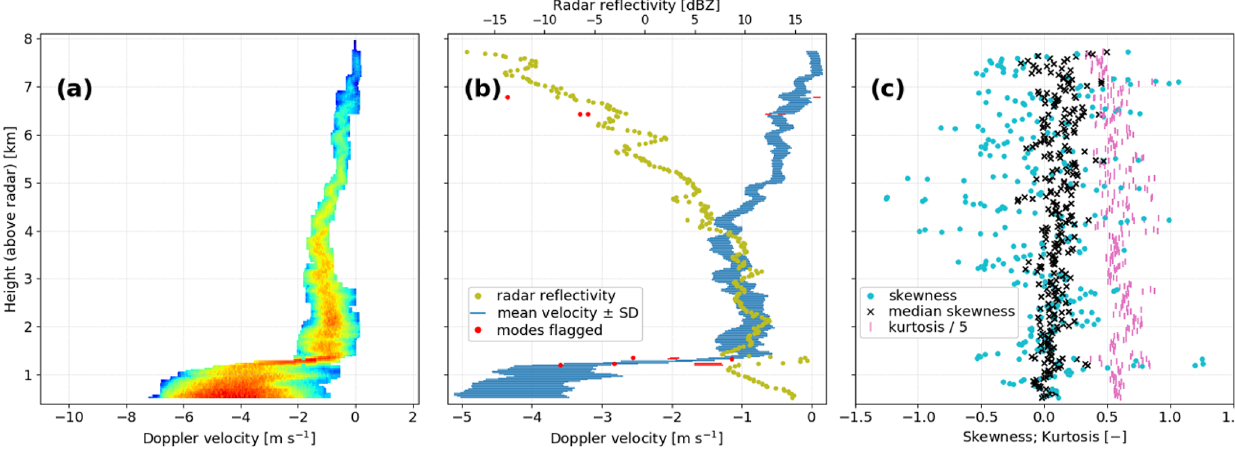
Figure 10. Summary of analysis results for a birdbath scan recorded in light rain at DWD’s Borkum (ASB) radar in April 2021 (data timestamp: 29 April 2021, 14:14:12UTC), analogous to Fig. 8 but with different scaling of x and y